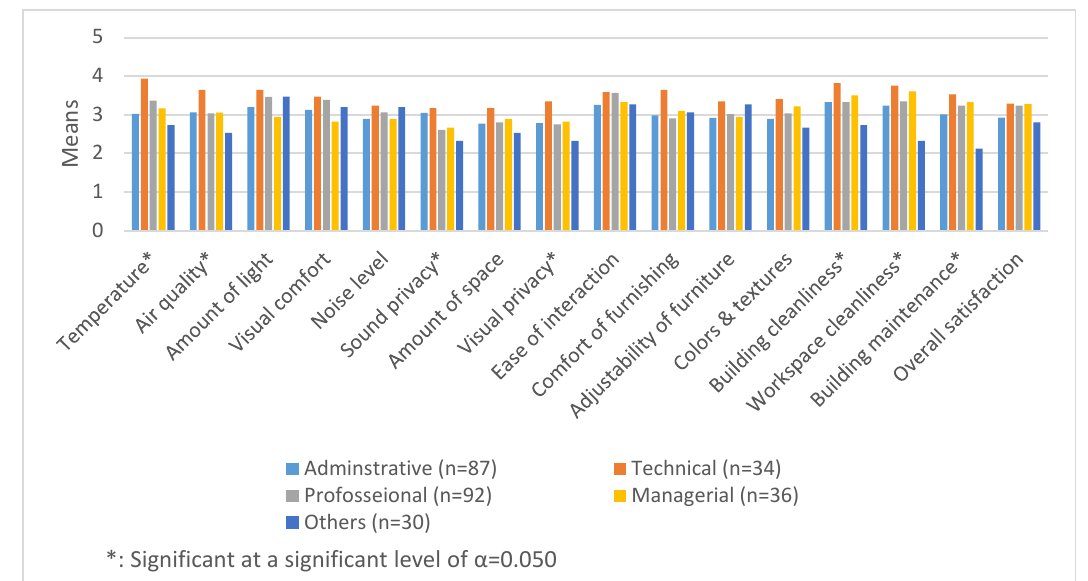
Figure 3. The impact of job category on satisfaction with IEQ factors.